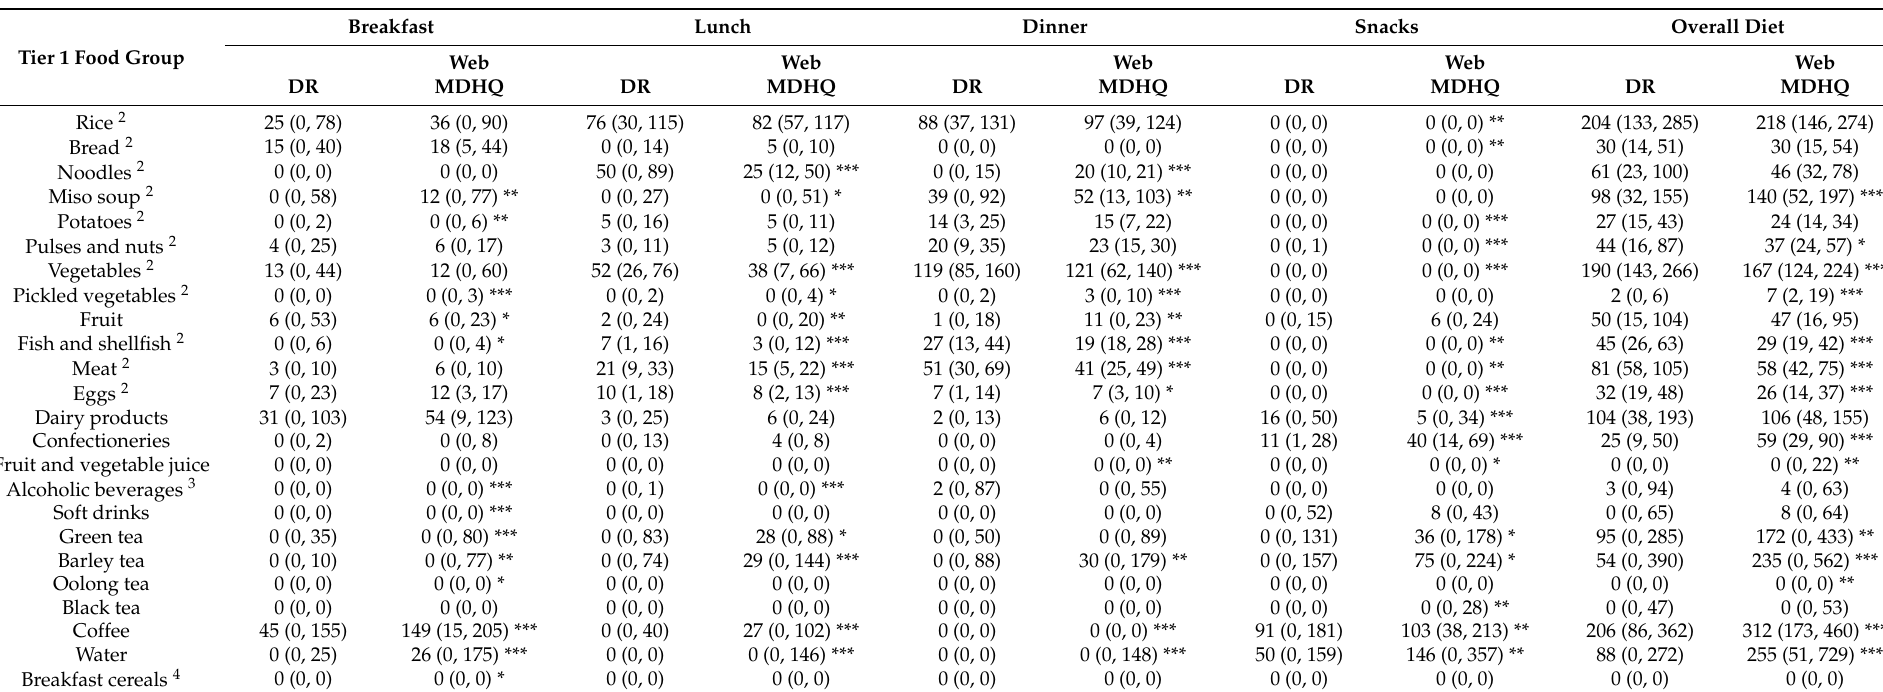
Table 2. Median estimates of daily intakes of Tier 1 food groups (in grams per day) derived from the 4-day weighed dietary record (DR) and those derived from the web version of the Meal-based Diet History Questionnaire (MDHQ) in 111 Japanese women, according to meal type 1